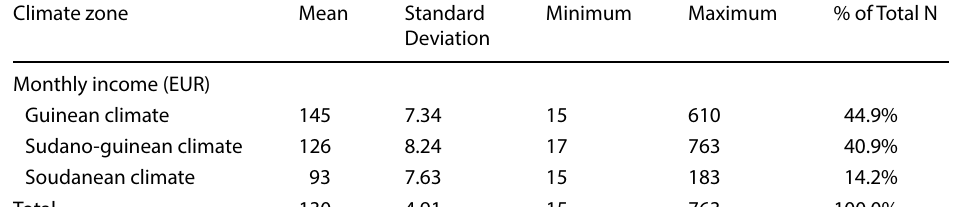
Fig. 2 Circular diagram sum- marizing in percentage the perception of 381 Ivorian’s fishermen of causes and driv- ers of climate